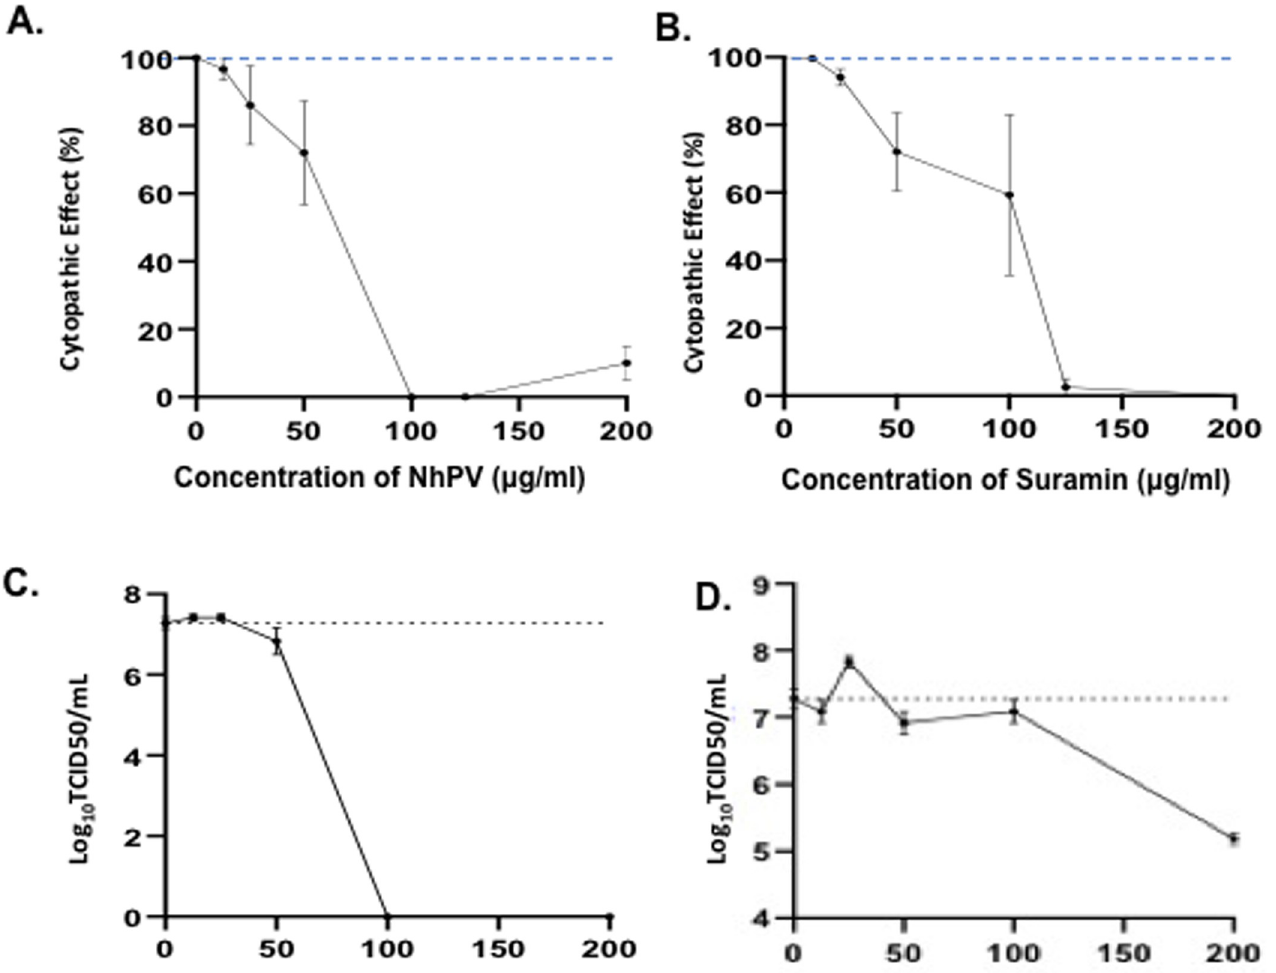
Fig 6. Inhibitory effect of NhPV and Suramin on SARS-CoV-2 infection-induced cytopathic effects. Vero cells were infected with a wild type SARS-CoV-2 virus (hCoV- 19/Canada/ON-VIDO-01/2020) in the presence or absence of different concentrations of NhPV and Suramin. After 72 hrs pi., the SARS-CoV-2 infection-induced cytopathic effects in Vero cells were monitored. Error bars represent variation between triplicate samples, and the data of (A) and (B) are representative of results obtained in three independent experiments. Also, the supernatants from SARS-CoV-2 infected cultures in the presence of different concentrations of NhPV (C) or Suramin (D) were collected and the levels of progeny virus produced from infected cultures were titrated by TCID 50 assay in Vero cells. The results are the mean ± S.D. of duplicate samples, and the data are representative of results obtained in two independent